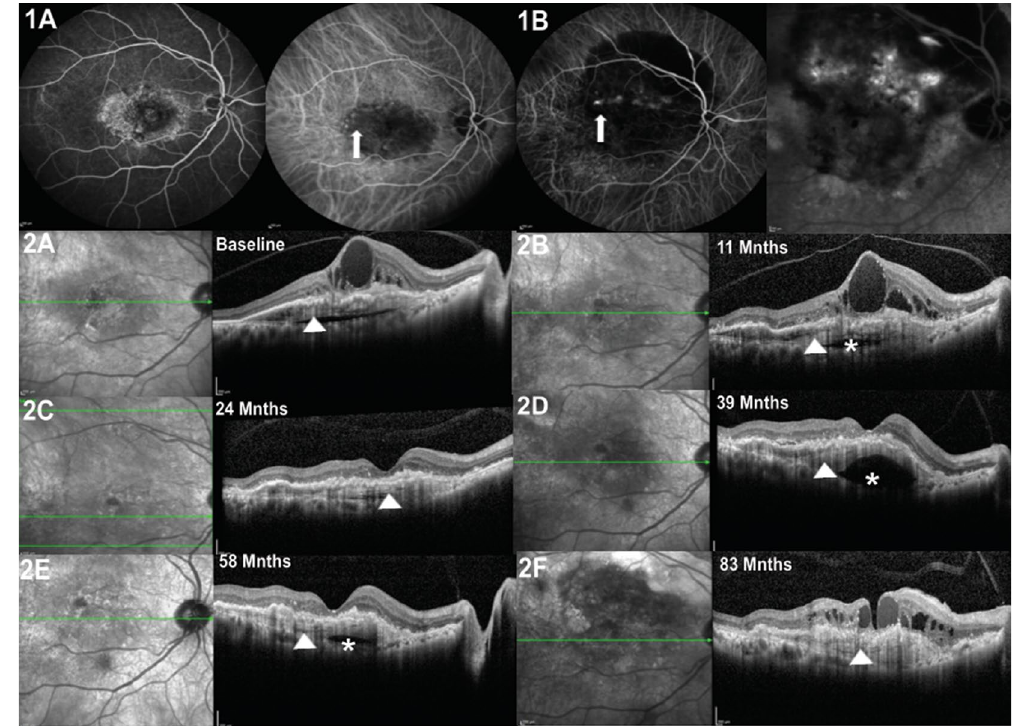
Figure 2. Right eye of a 79-year-old female with the occurrence of polypoidal choroidal vasculopathy (PCV) and de novo multilayered pigment epithelial detachment (DN-MLPED). Angiography ( A ) shows a neovascular network with polyps (arrow), more evident on follow up indocyanine green angiography (ICGA; B ). Serial cross-sectional optical coherence tomography (OCT) over 83 months shows increasing multilayering under the retinal pigment epithelium (RPE; arrowhead) with subretinal hyperreflective material (SHRM; Red *) ( A – F ). The waxing and waning nature of choroidal cleft is seen (White